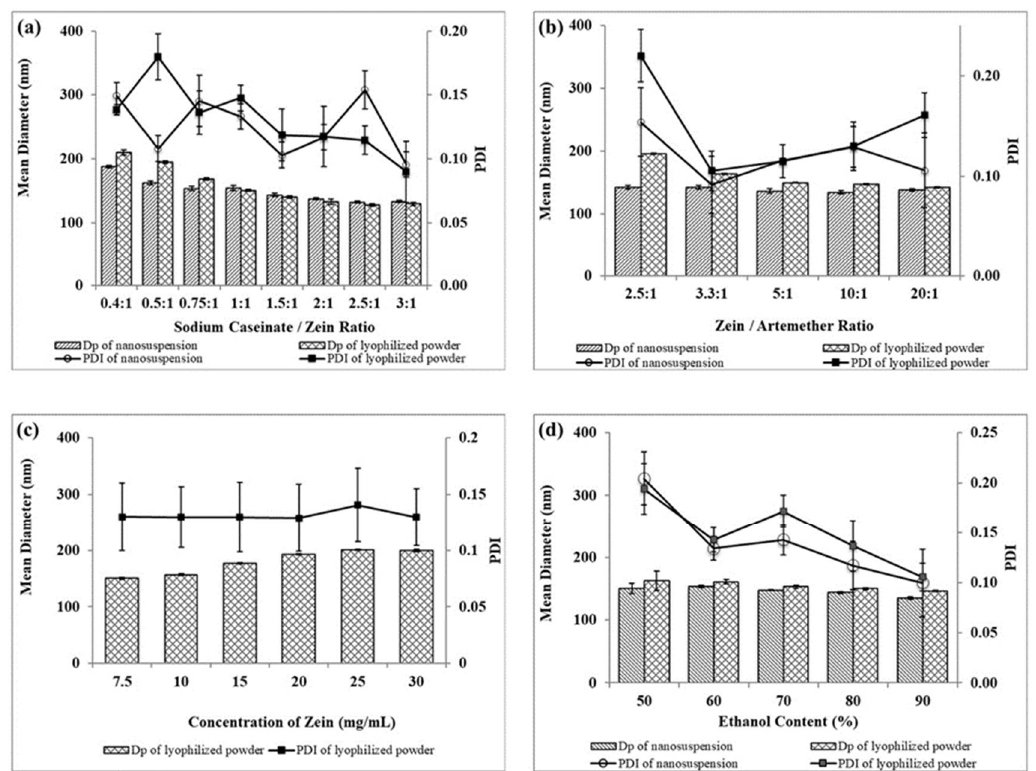
Figure 4. Effects of formulation variables ( a ) sodium caseinate/zein ratio, ( b ) zein/artemether ratio, ( c ) concentration of zein and ( d ) ethanol content on particle size and polydispersity index (PDI) of artemether-loaded zein nanoparticles in nanosuspension and lyophilized powder forms. The experimental data were obtained from the nanoparticles prepared from three different batches ( n = 3); symbols represent mean values while error bars represent SD.